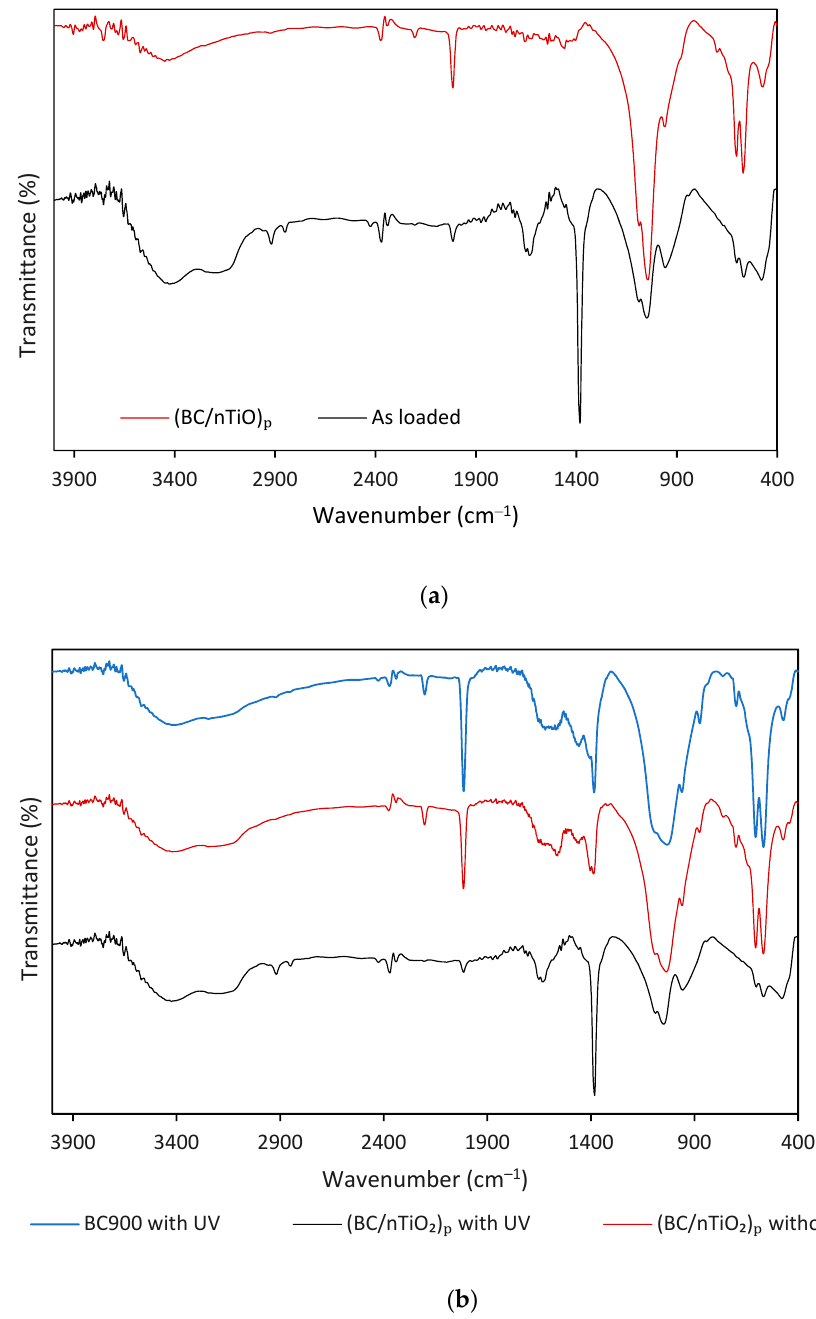
Figure 9. FTIR analysis for ( a ) As loading effect on (BC/TiO 2 ) P structure and ( b ) UV and nTiO 2 effect on BC900 structure.